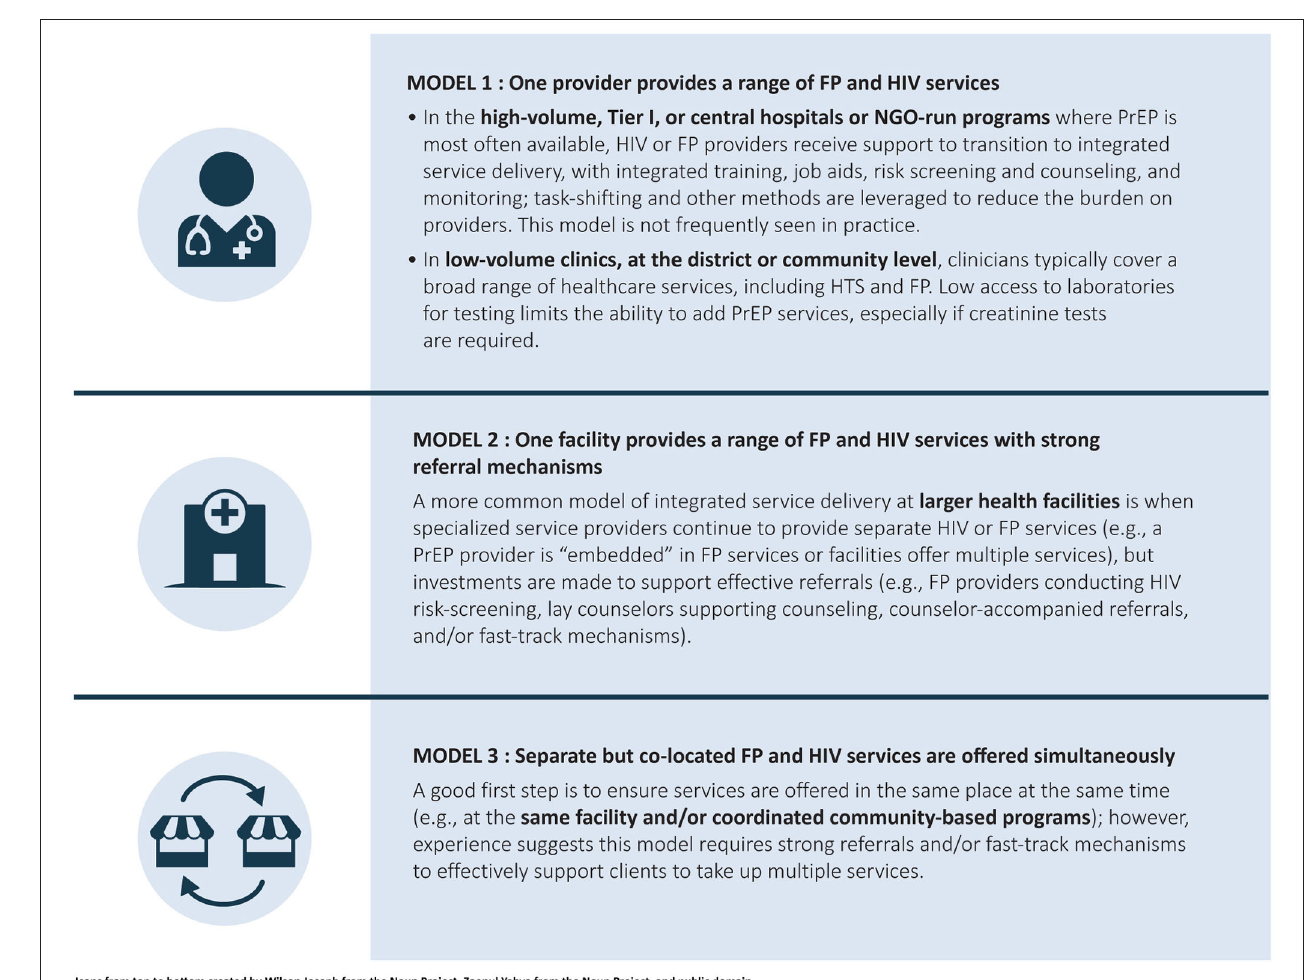
FIGURE 3 | PrEP-FP integration models. PrEP, pre-exposure prophylaxis; NGO, nongovernmental organization; FP, family planning; HTS, HIV testing